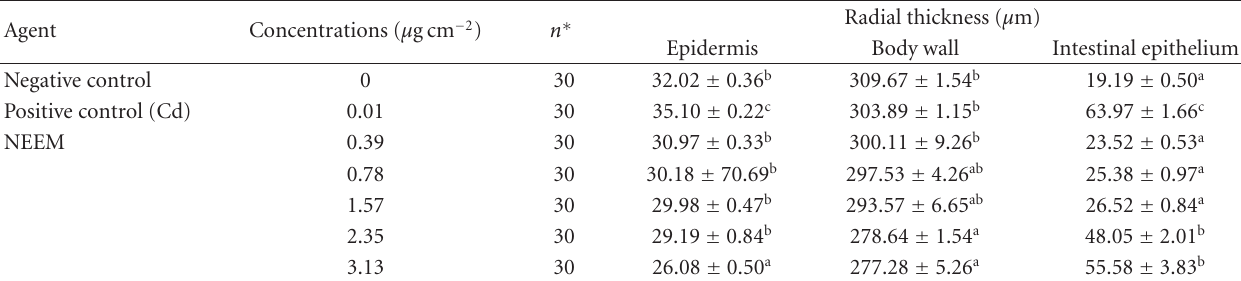
Table 4: Radial thickness of epidermis, body wall, and intestinal epithelium of Pheretima peguana exposed to commercial neem extract (NEEM) and Cd for 48h.